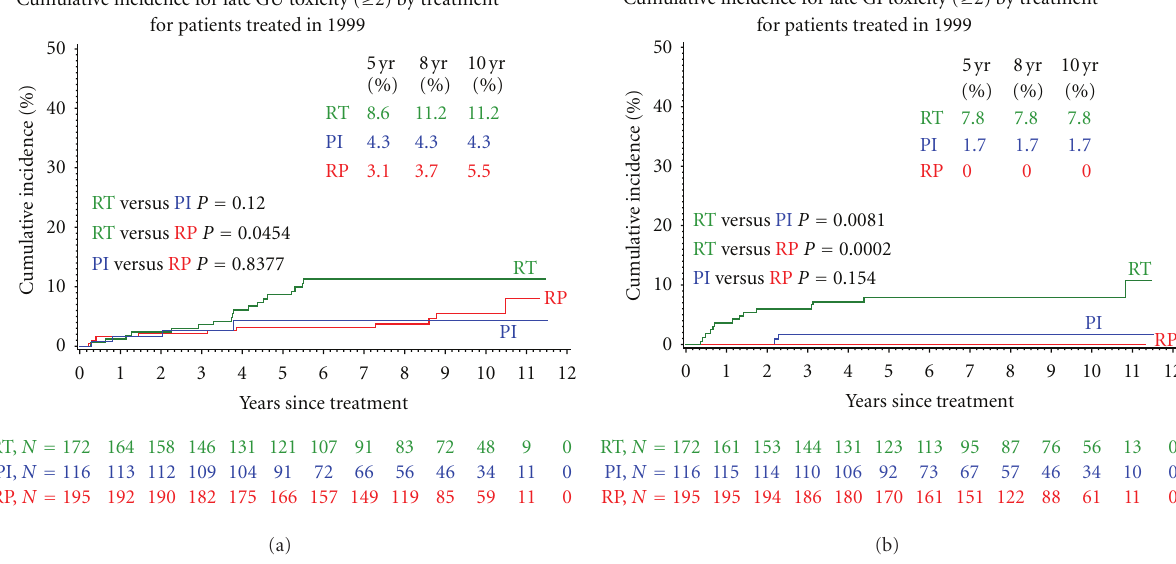
Figure 1: (a) Cumulative incidence curves of GU toxicity, ≥ grade 2 for patients treated in 1999 with external beam radiation therapy, radical prostatectomy, or prostate brachytherapy. (b) Cumulative incidence curves of GI toxicity, ≥ grade 2 for patients treated in 1999 with either external beam radiation therapy, radical prostatectomy, or prostate brachytherapy. Table 2: Distribution of Toxicities Requiring Interventions (Corresponding to grade ≥